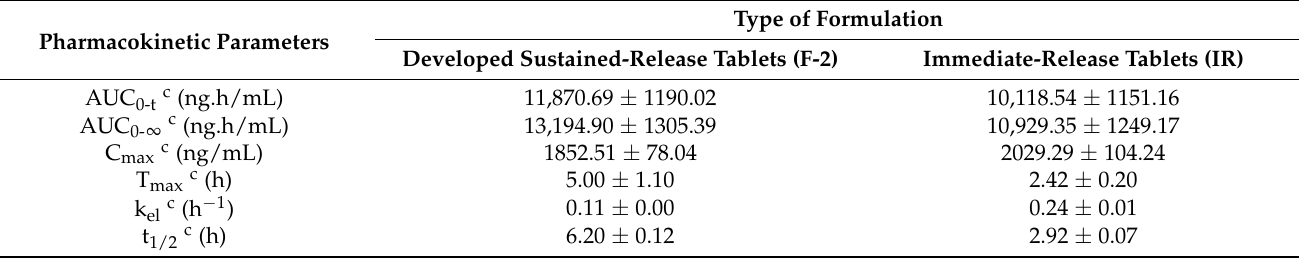
Figure 9. Mean plasma concentrations (ng/mL) recorded over 24 h for acyclovir administered as immediate release formulation versus sustained release formulation. Table 5. Mean pharmacokinetic profile of acyclovir SR tablets.